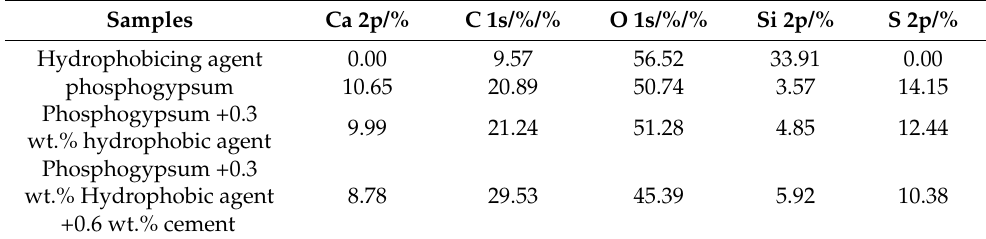
Figure 5. Total XPS spectrum of gypsum sample. Table 5. Contents of each element in gypsum samples.